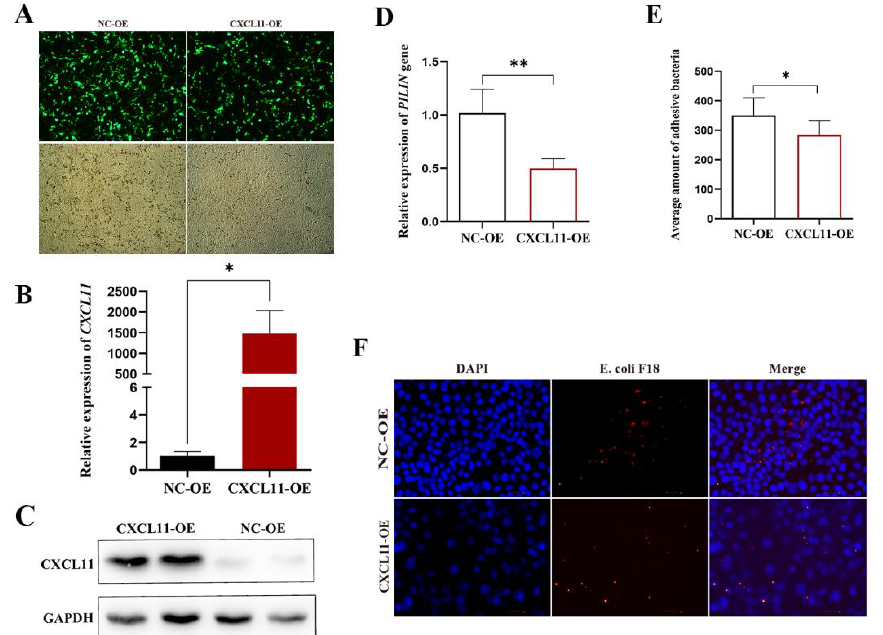
Figure 2. Overexpression of CXCL11 improves E. coli F18 resistance. ( A ) The expression of GFP. ( B ) The mRNA expression level of the CXCL11 gene; ** p < 0.01 and * p < 0.05. ( C ) The protein expression level of the CXCL11 gene. ( D , E ) The detection of the relative quantification and bacteria enumeration. ( F ) Immunofluorescence assay. Red fluorescence signifies E. coli antibody, while blue fluorescence denotes nuclear staining via DAPI.